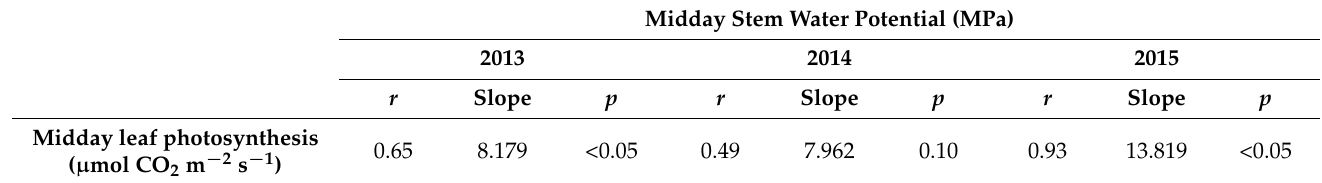
Table 4. Correlation coefficient ( r ), slope, and significance ( p -value) of the linear relationships between midday leaf photosynthesis and midday stem water potential for the 2013, 2014, and 2015